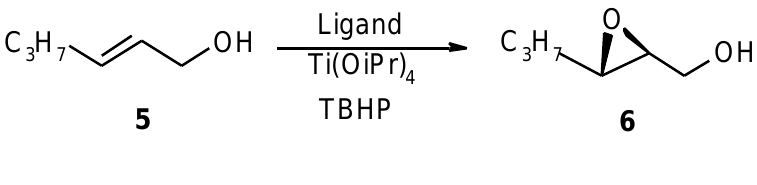
Table 2. Epoxidation of trans -hex-2-en-1-ol 5 with tBHP by L-(+)-polyester 3a-f/4 and Ti(OPr i )